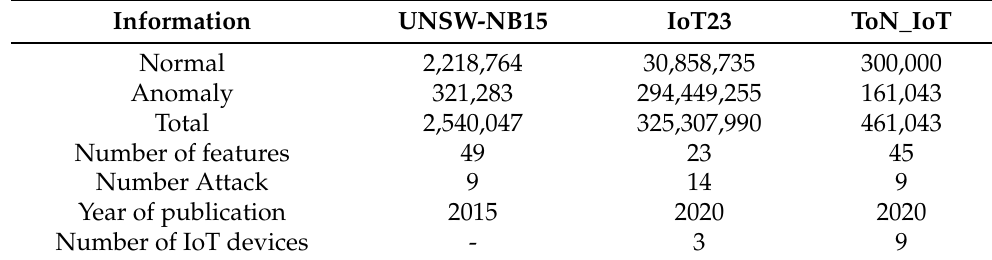
Table 2. Abstract information of each